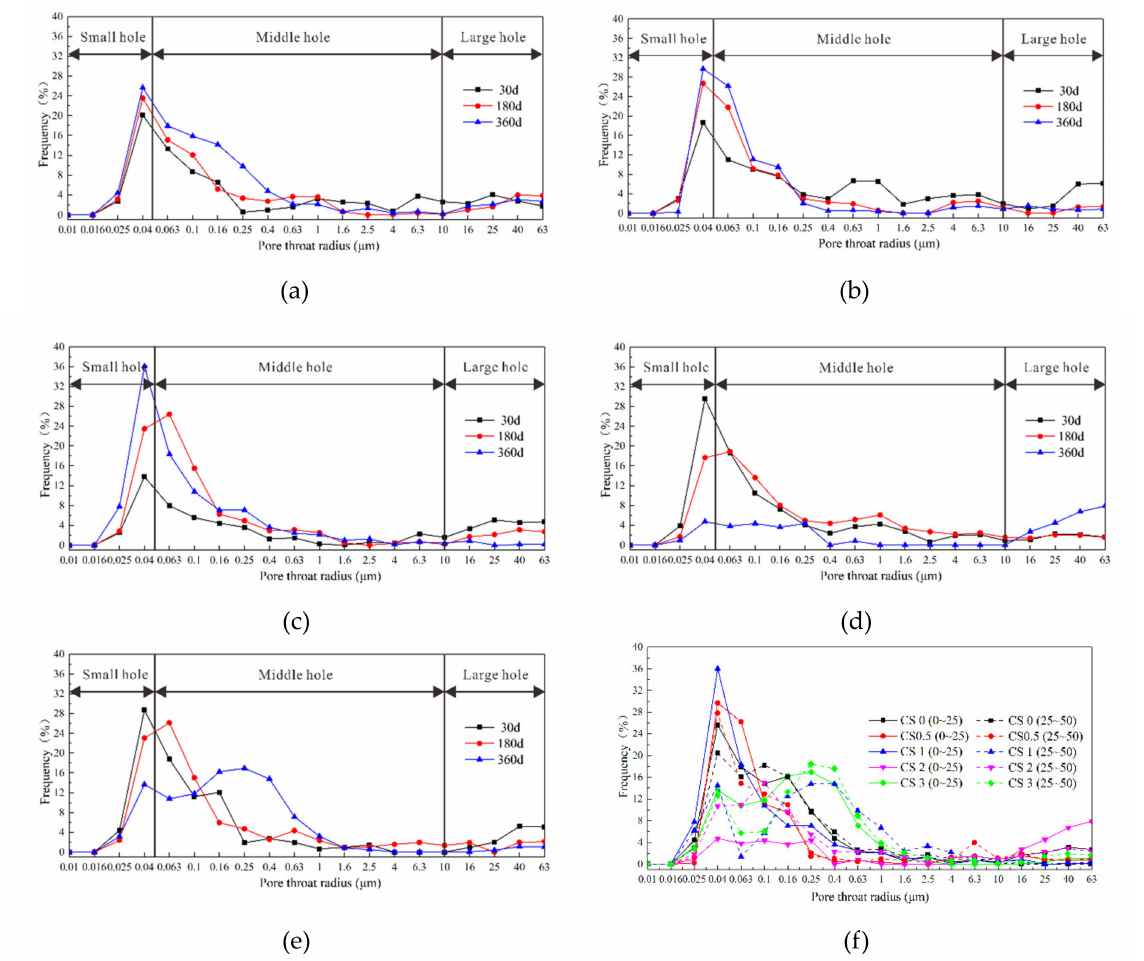
Figure 14. Evolution of concrete porosity after erosion by solution of different concentration: ( a ) CS0, ( b ) CS0.5, ( c ) CS1, ( d ) CS2, ( e ) CS3, ( f ) different depths after 360 d